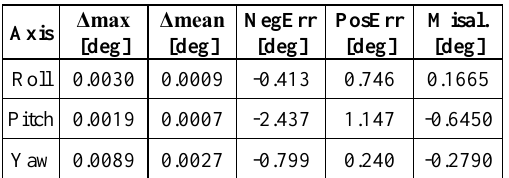
Table 3. Overview of deviations between motion model and complete set of measurements